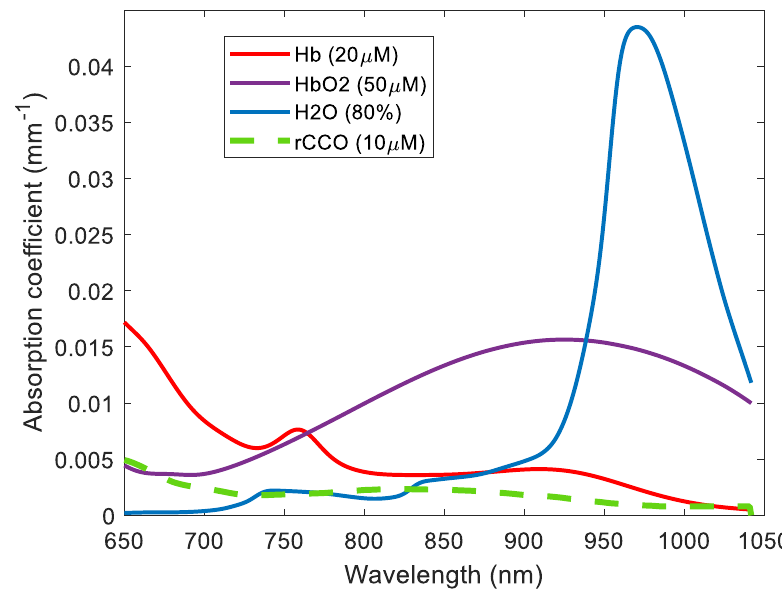
Figure 2. Absorption spectra of HHb, HbO 2 , H2O, and rCCO.